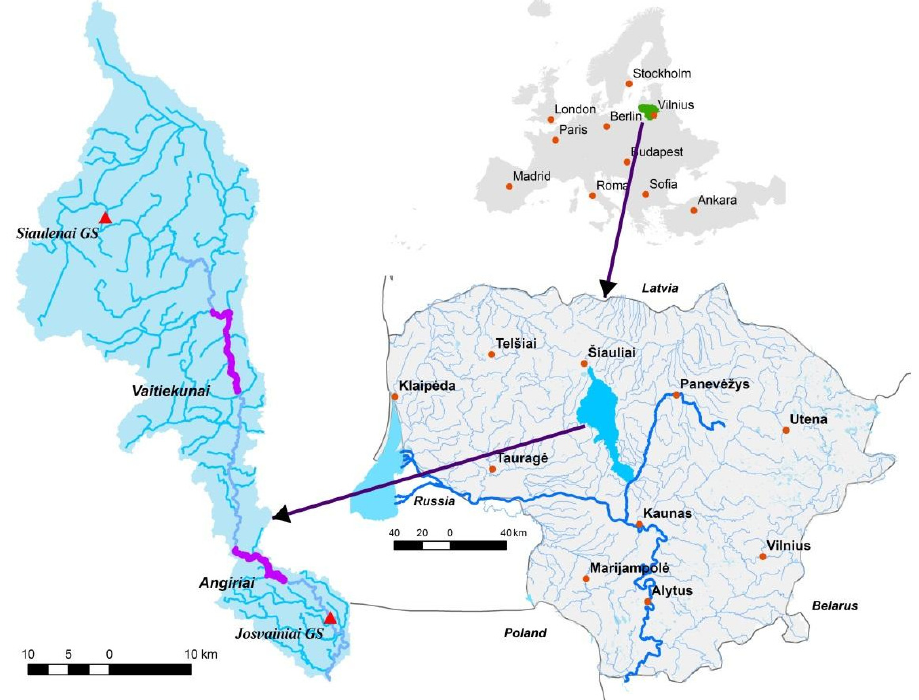
Figure 2. The catchment area of the Susve River with the location of the Angiriai and Vaitiekunai SHP reservoirs (purple color) and the Siaulenai and Josvainiai longstanding gauging stations (GS, red